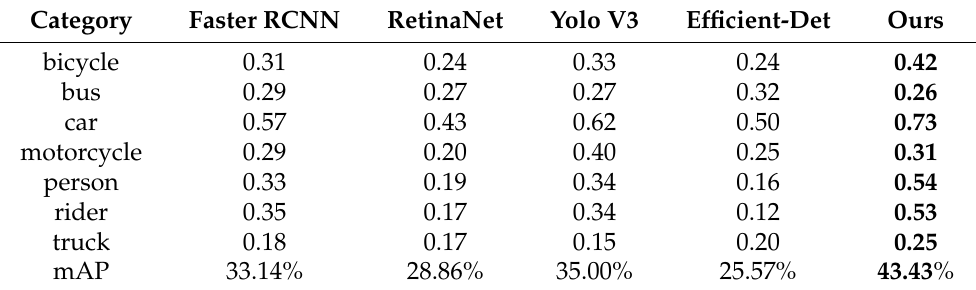
Figure 14. Testing results on Cityscapes for JSFR and object detection methods including Faster RCNN , Yolo V3 , RetinaNet , and Efficient-Det (electronic zoom-in recommended). Table 3. Comparison of AP and mAP between JSFR and object detection methods including Faster RCNN , RetinaNet , Yolo V3 , and Efficient-Det on Cityscapes .